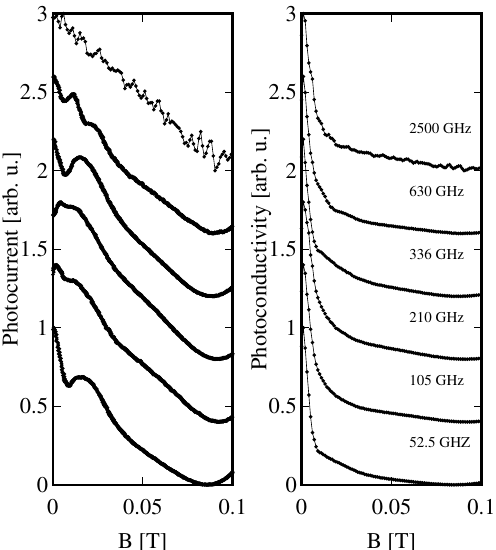
Figure 8. Left : photocurrent (normalized to the value at B = 0) measured at monochromatic excitation with radiation of frequency indicated in the right panel; Right : photoconductivity (normalized to the value at B = 0) at indicated frequencies. The curves in both panels are shifted vertically for better